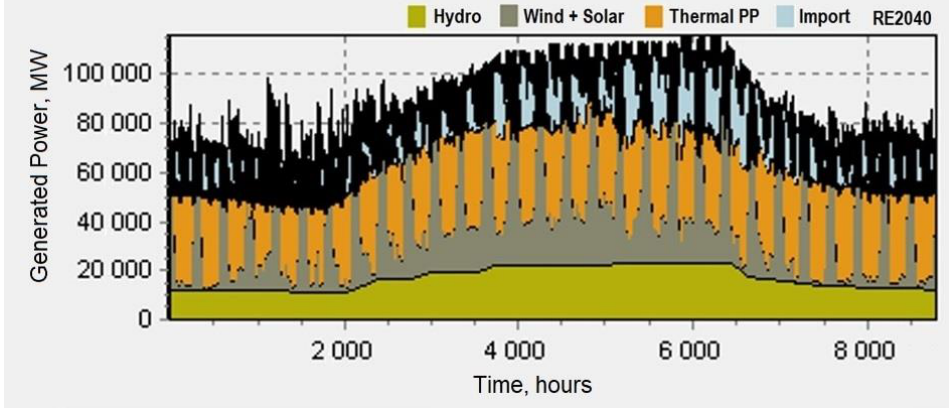
Figure 7. RE2040. Electricity demand and production in 2040 by